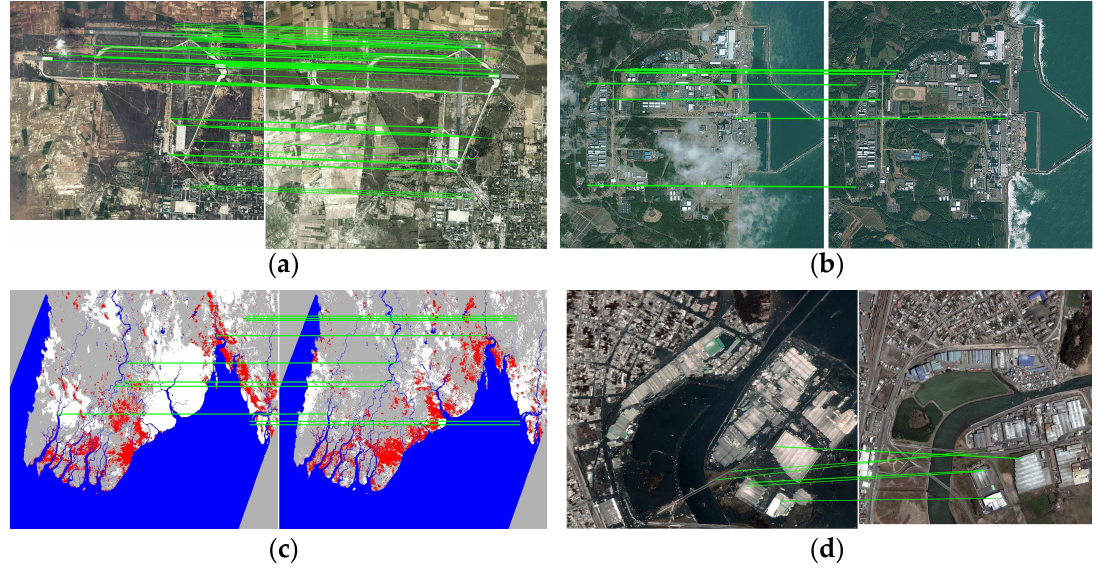
Figure 10. Matching results of the proposed method on real image pairs. The lines connect matching intersection points on ( a ) Data set 2-1; ( b ) Data set 2-2; ( c ) Data set 2-3; ( d ) Data set 2-4. Table 3. Experimental results of real remote sensing images.